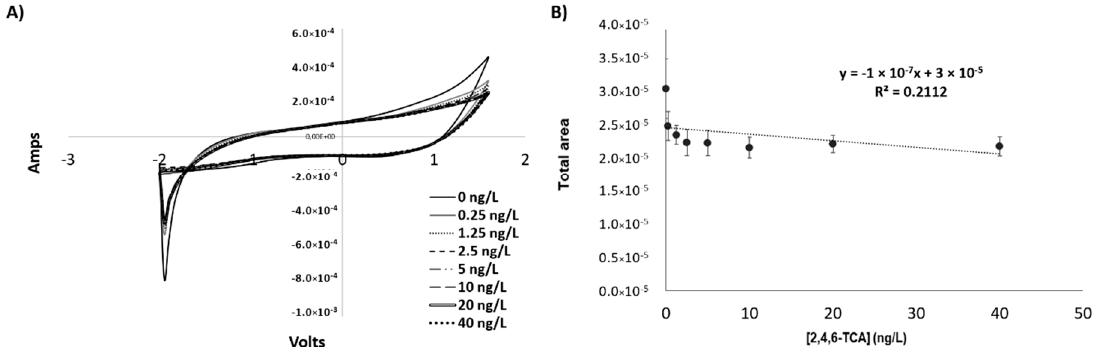
Figure 9. Cyclic voltammogram for ACN/H 2 O mixtures (1:1 ( v / v ) with 0.1 M of TBAP) without (0 ng/L, black line) and with 2,4,6-TCA addition (0.25 to 40 ng/L) ( A ); Schematic representation of the calibration curve obtained for different 2,4,6-TCA concentrations in ACN/H 2 O mixtures (1:1 ( v / v ) with 0.1 M of TBAP) ( B ).